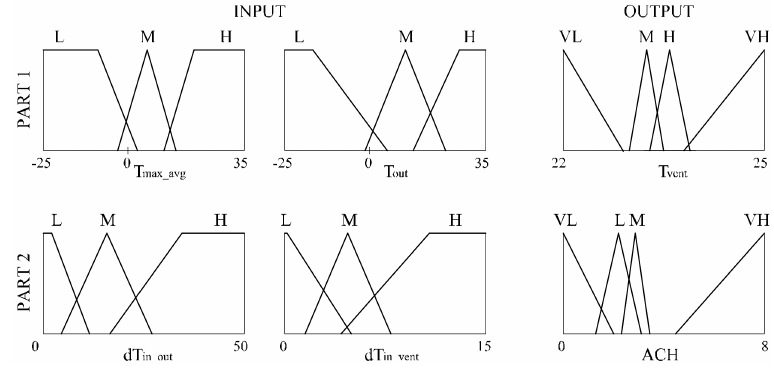
Figure 12. Tuned MF for case O1-TCC.